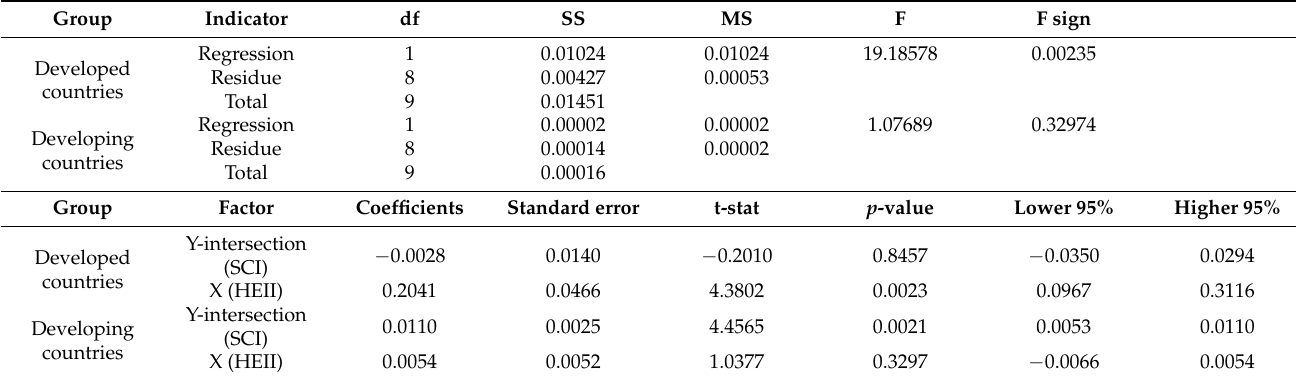
Table 7. Indicators of analysis of variance for the Social Content Index.